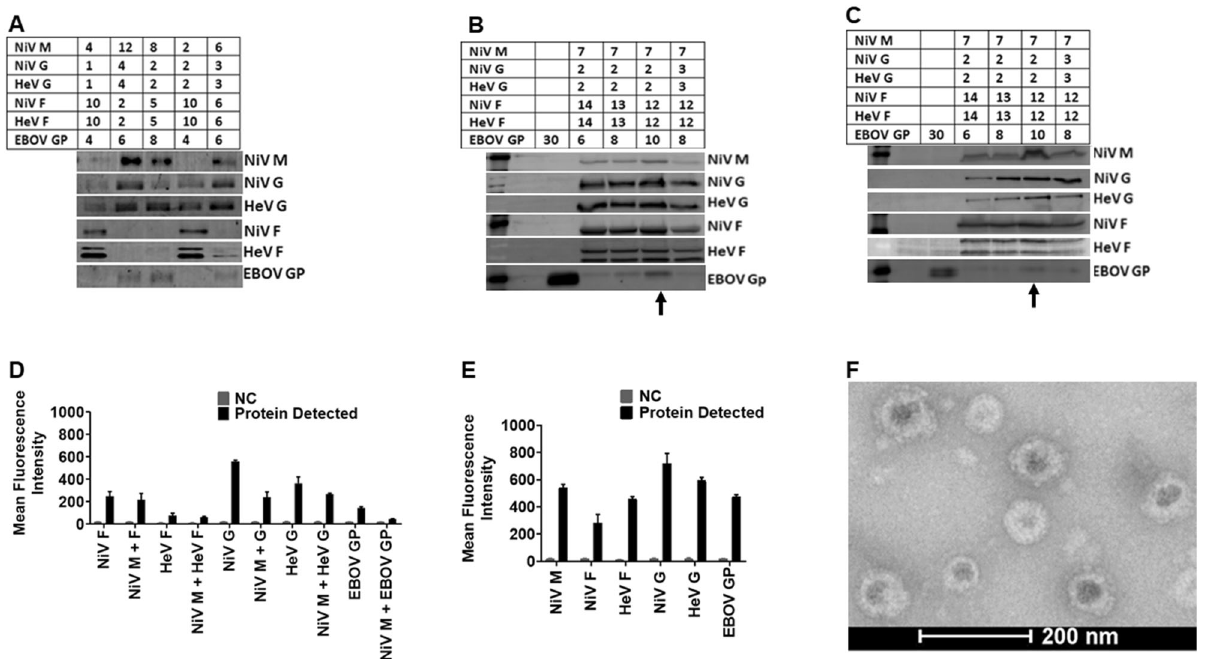
Fig. 2 Optimized production of NiV-HeV-EBOV VLPs and their protein detection using multiple techniques. A Different amounts of DNA (µg) were used to transfect HEK 293T cells to determine the closest range for each target protein for optimized production detected by Western Blot analysis (WBA). B Shows the best VLP production DNA ratio detected by WBA. C WBA detection of proteins in cell lysate of cells transfected to produce VLPs in ( B ). D The cell surface expression (CSE) of the target proteins analyzed by Flow Cytometry (FC). E Detection of the target proteins on VLPs using Flow Virometry (FV). F A micrograph of the produced VLPs viewed using a FEI T20 electron microscope.